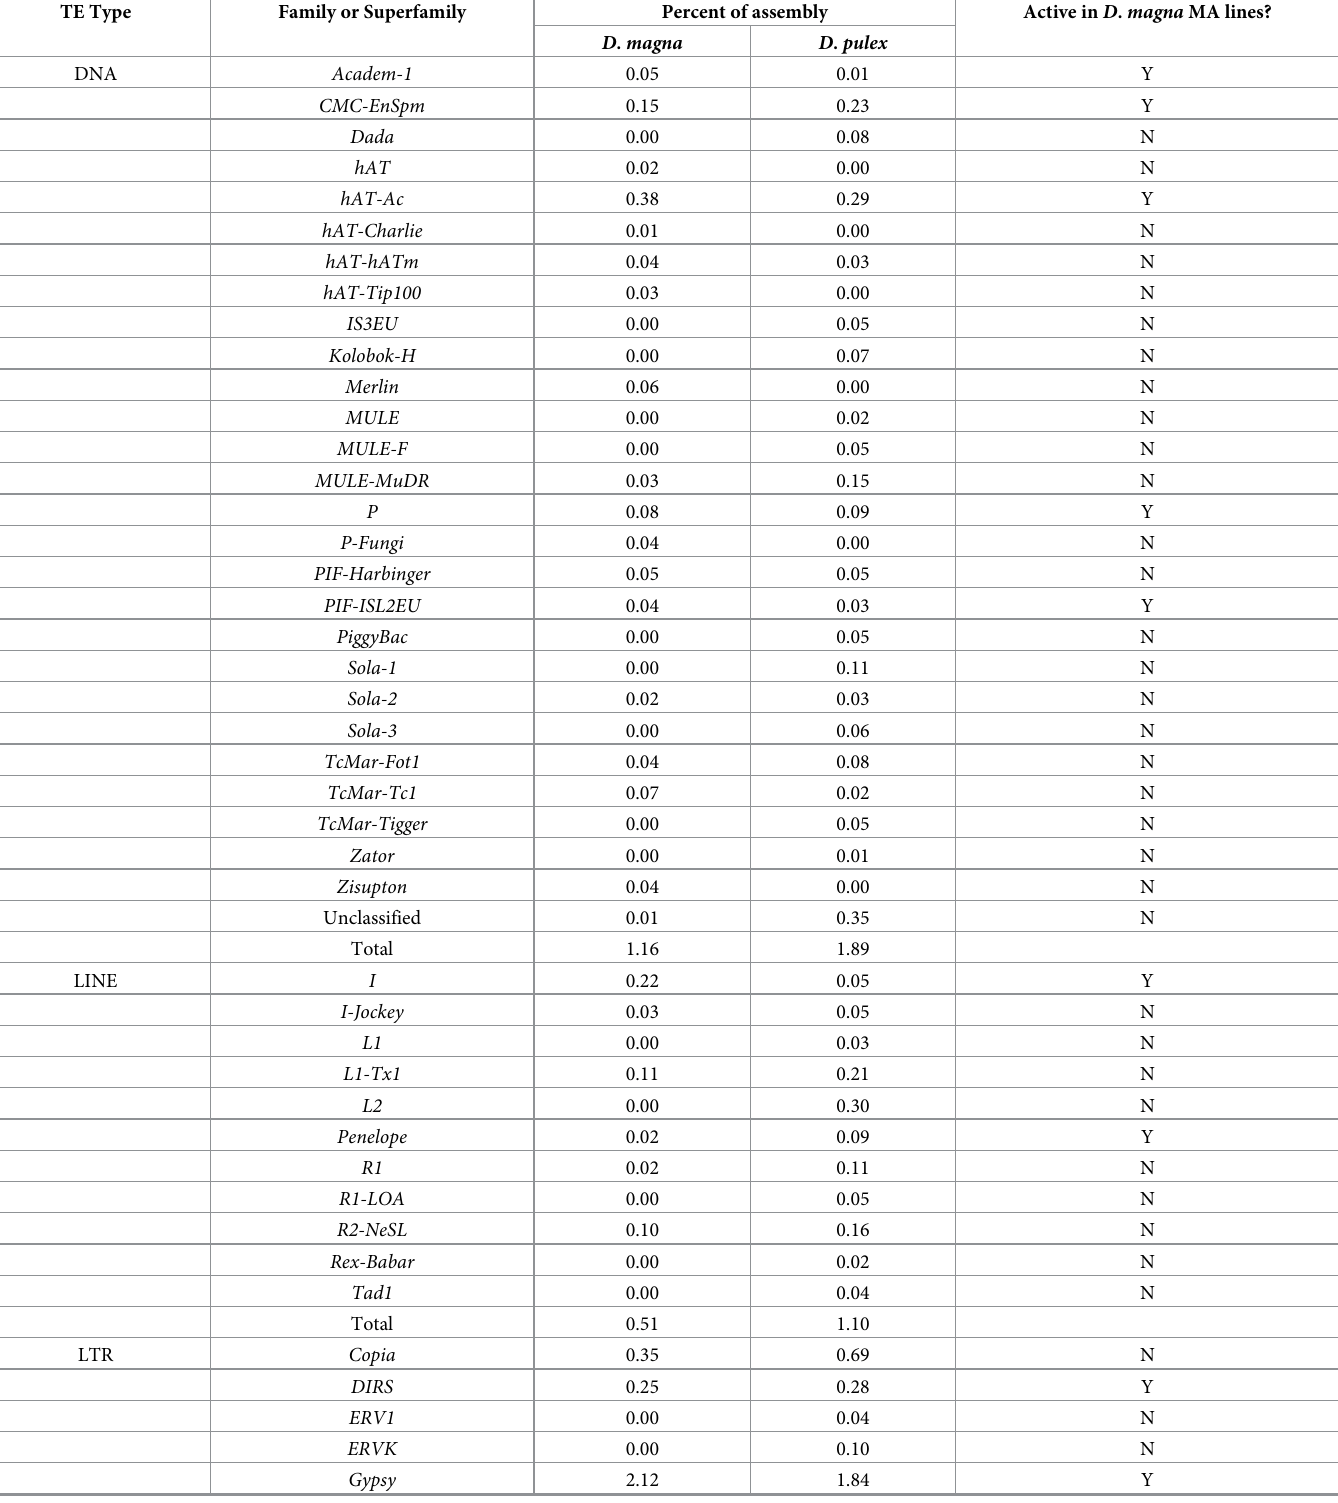
Table 1. Abundance of TE types by family or superfamily for Daphnia magna (averaged across nine genotypes) and D . pulex (PA42 [PRJNA307976]). TE